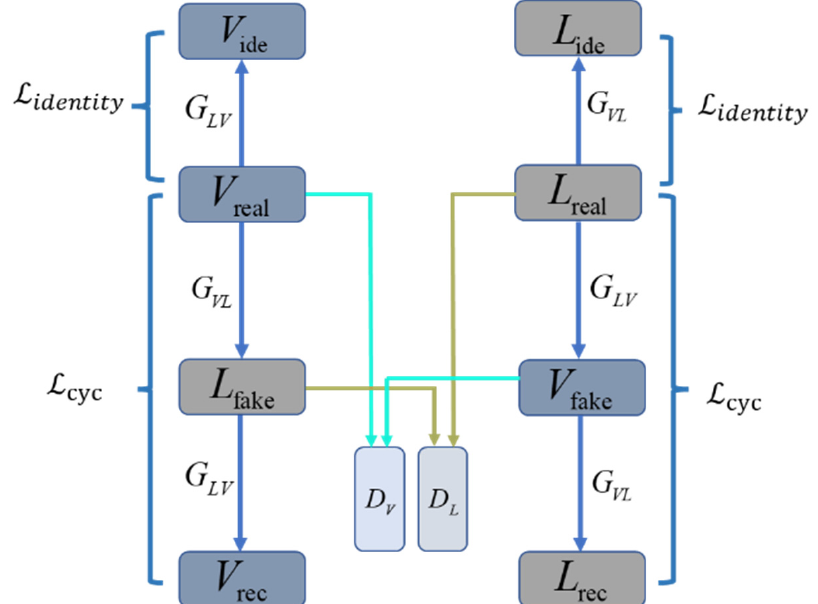
Figure 9. Modified network structure.